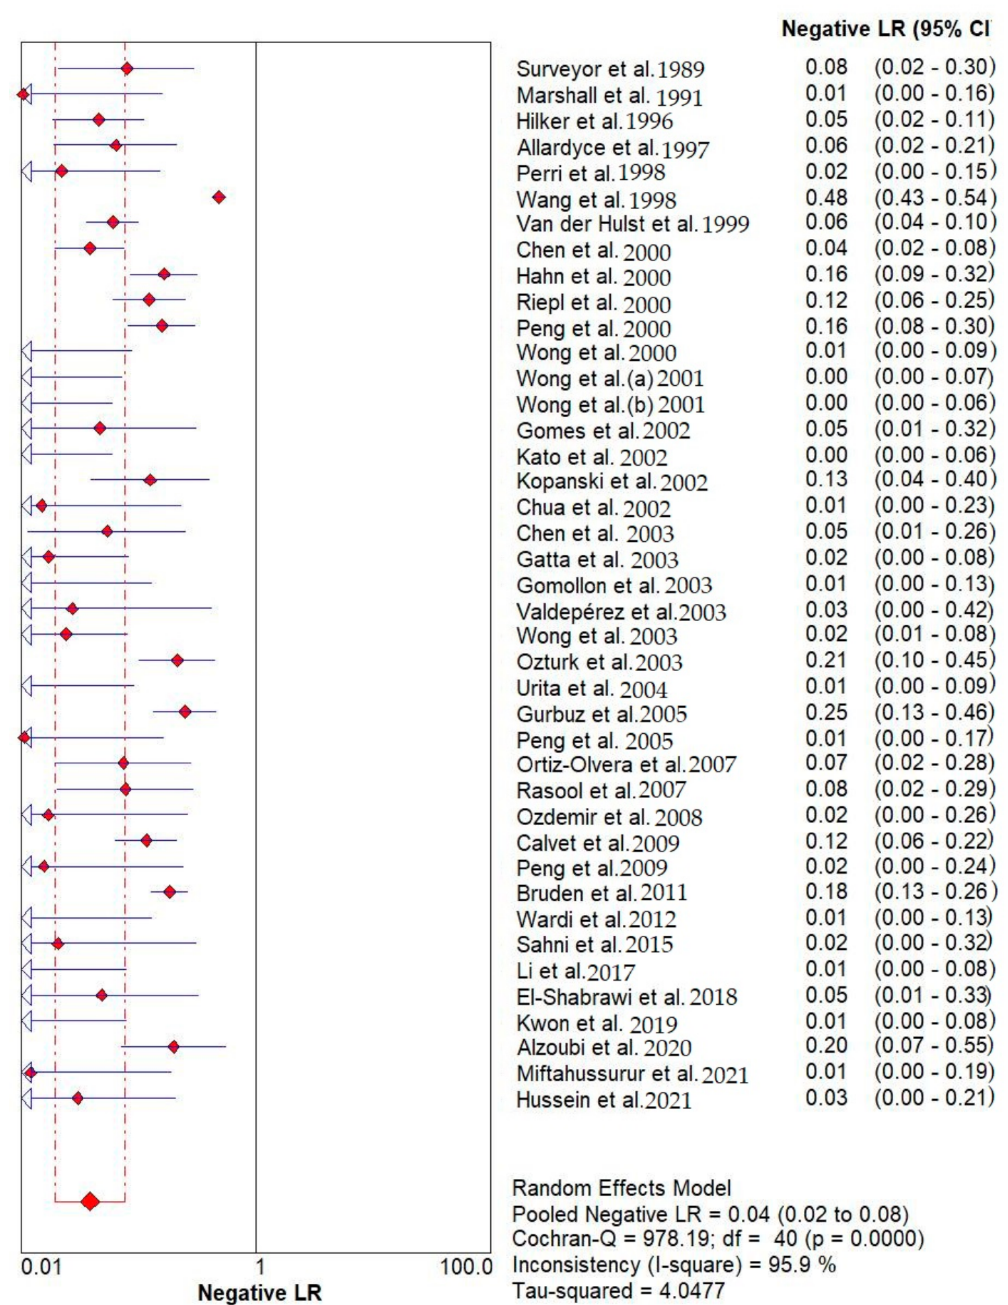
Figure 5. Pooled urea breath test result. Overall likelihood ratio for negative test